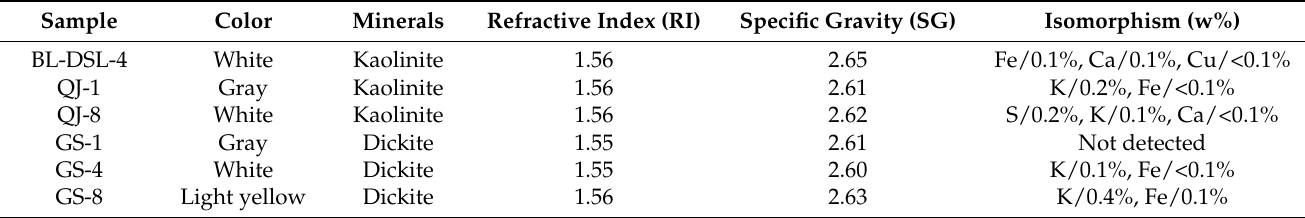
Table 1. Mineral composition of the